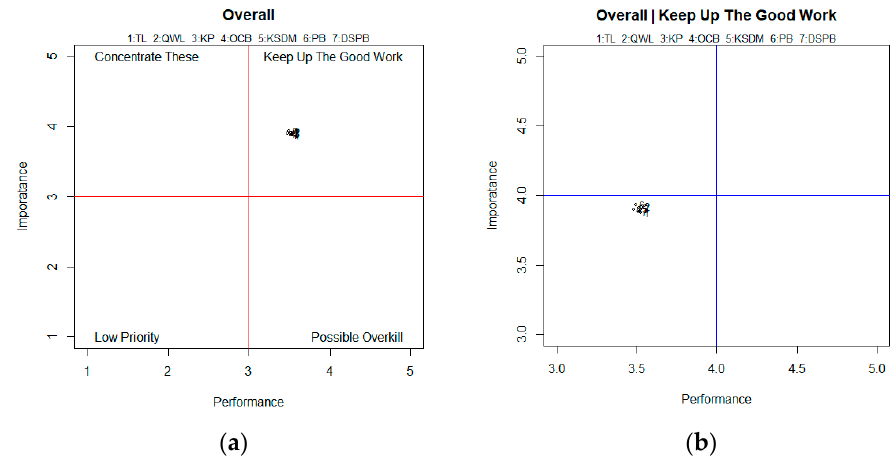
Figure 11. ( a ) IPA Cartesian Diagram of Overall. ( b ) IPA Cartesian Diagram of Keep up the Good Work Quadrant of Overall.